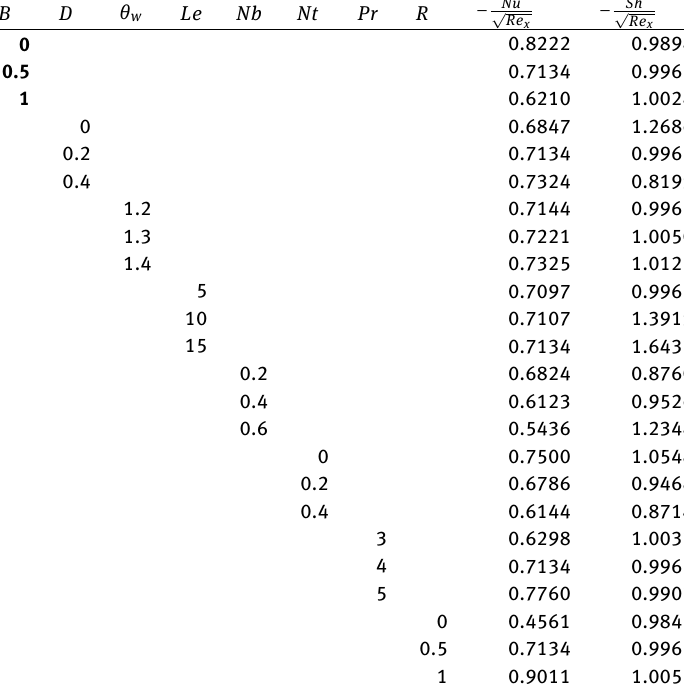
Table 4: Variation of Nusselt number and Sherwood number for different physical parameter. B D θ w Le Nb Nt